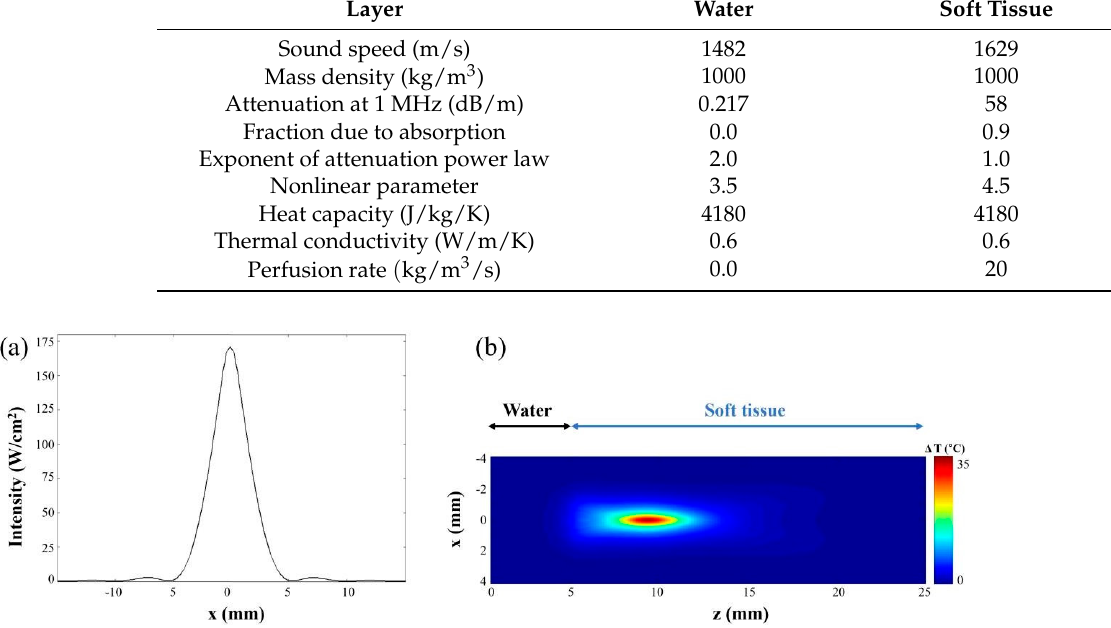
Figure 4. Simulated acoustic characteristics of the 5.3 MHz transducer when HIFU signal is applied. ( a ) The intensity of transducer at the focal point and ( b ) the temperature change region along the axial directions based on the linearized Khokhov–Zabolotskaya–Kuznetsov (KZK) wave equation and the bioheat transfer (BT) equation. Table 1. Parameters used in the simulation.